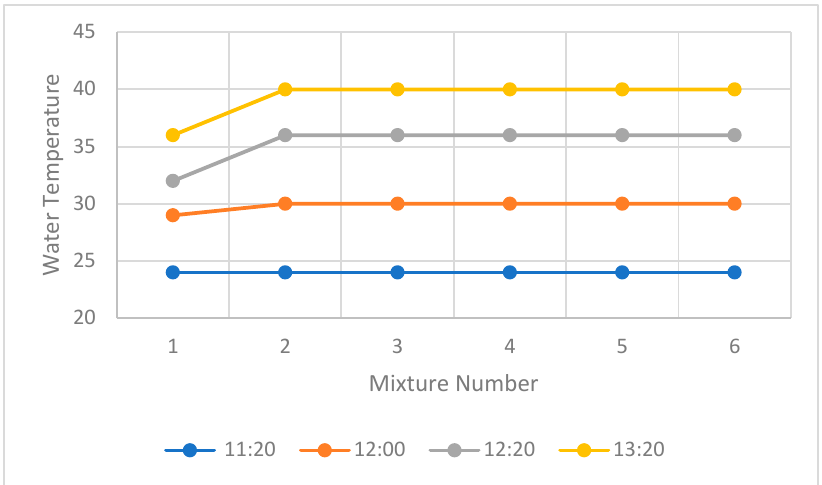
Figure 2. Variation of contaminated water hybrid nanofluid mixtures with time.